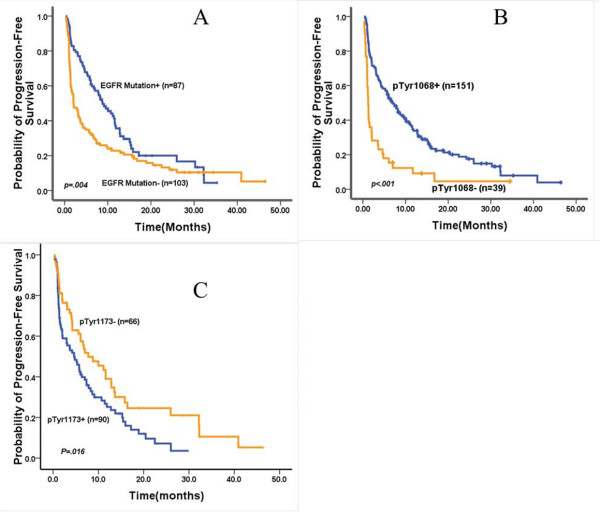
Progression-free survival curves according to epidermal growth factor receptor mutational status (A), phosphorylated tyrosine (pTyr) 1068 expression (B), pTyr1173 expression (C).